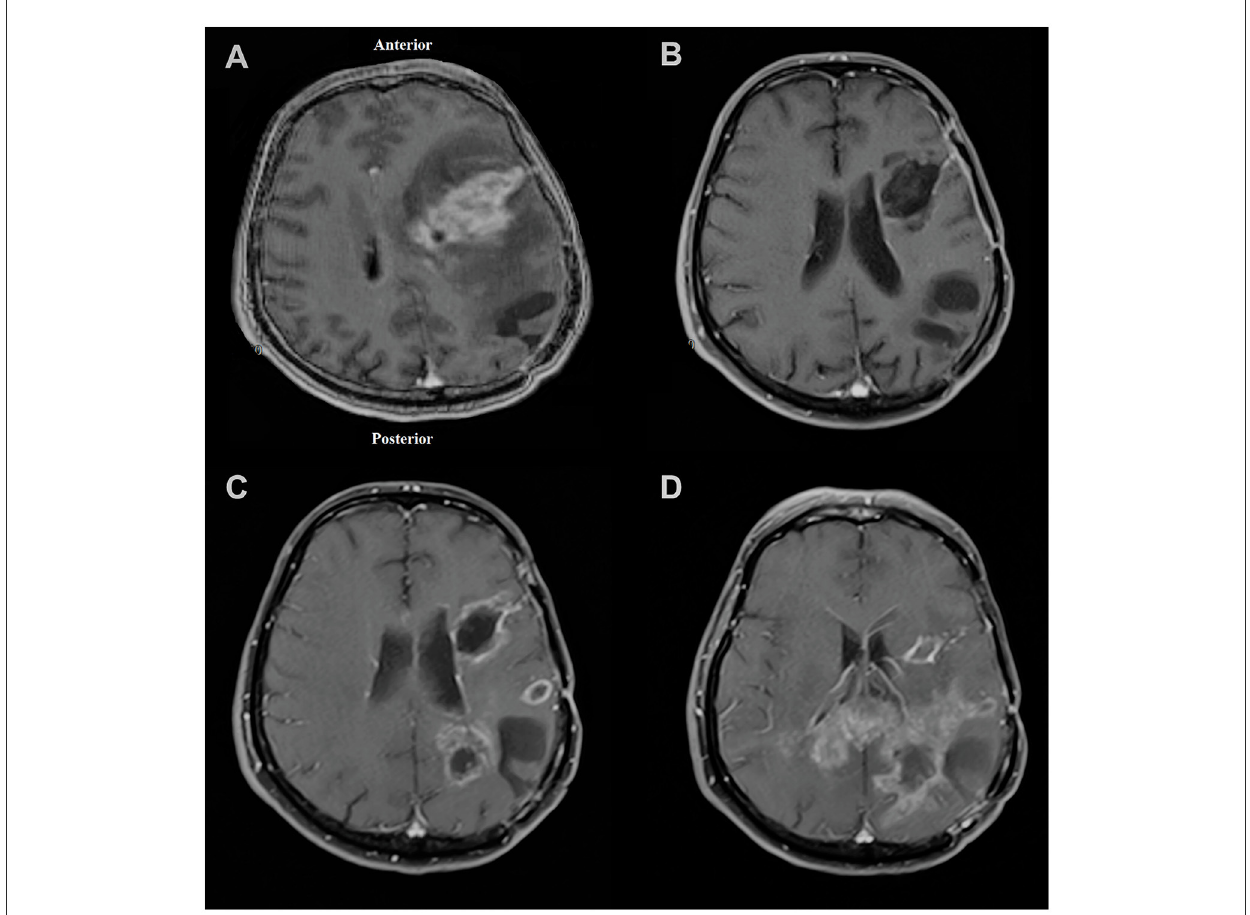
FIGURE5 Magnetic resonance imaging of the patient in (A) November 2018 showing left frontal lesion and evidence of craniotomy related to previous surgery for parietal lesion 1 month earlier; (B) February 2019 with no obvious evidence of recurrence at the time of injection to the frontal focus; (C) December 2019 showing first evidence of recurrence of tumor mostly at the parietal site; (D) March 2020 showing left frontal focus had no prominent recurrence; however, the size of the left parietal focus increased and extended to the contralateral hemisphere through the corpus